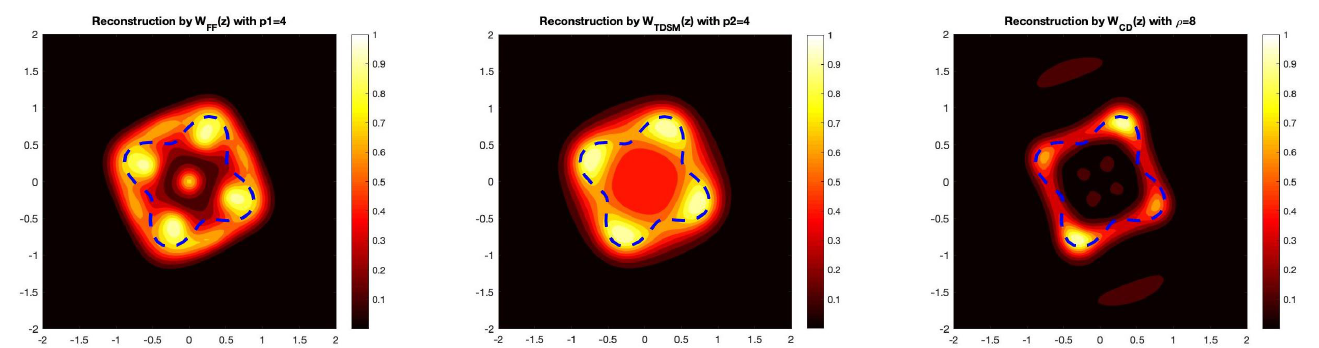
Figure 3. The reconstruction of the flower-shaped obstacle by the three direct sampling methods. In this example, we take δ = 0.05, which corresponds to a 5% noise level.